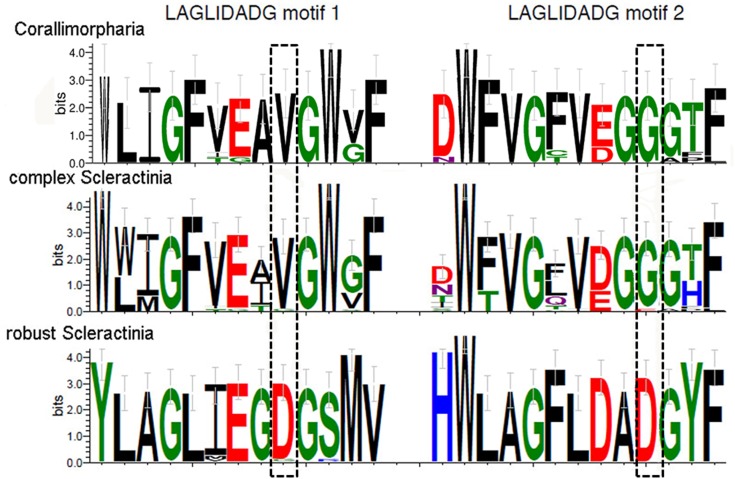
Sequence logo of the two LAGLIDADG motifs found in Corallimorpharia, complex Scleractinia and robust Scleractinia.All homing endonucleases have two LAGLIDADG motifs. Both motifs in complex Scleractinia are lacking the conserved acidic residues (D or E, highlighted by the dashed boxes) necessary for metal-ion binding and catalysis. Amino acids are color-coded according to chemical properties (blue, basic; red, acidic; green, polar; black, hydrophobic). Information content at each position (in bits) is represented by the height of the amino acid and its estimated variance is shown by the error bar. A score of 4.2 bits corresponds to high conservation, while a score of 0 corresponds to low conservation.